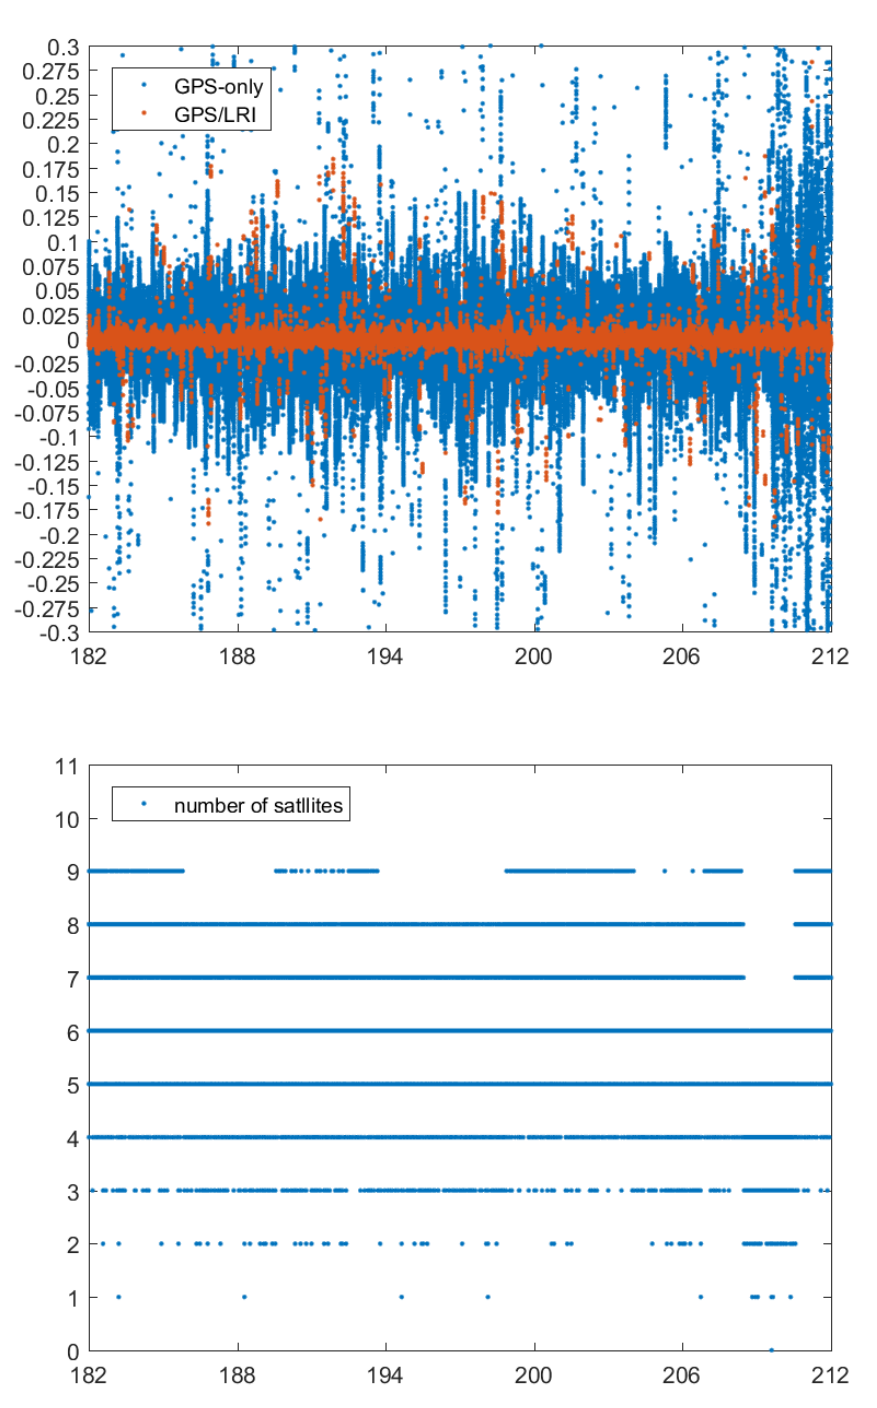
Figure 17. Day 182–212 KBR residuals (unit: m) for the GPS/LRI and GPS-only relative orbit and number of satellites.